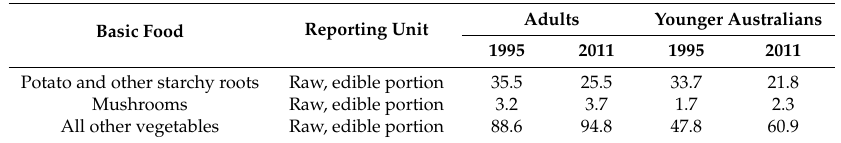
Table 3. Reported intake of vegetables (kg/person/year) by adult (19 years and above) and younger Australians (2 to 18 years) in 1995 and 2011. 1